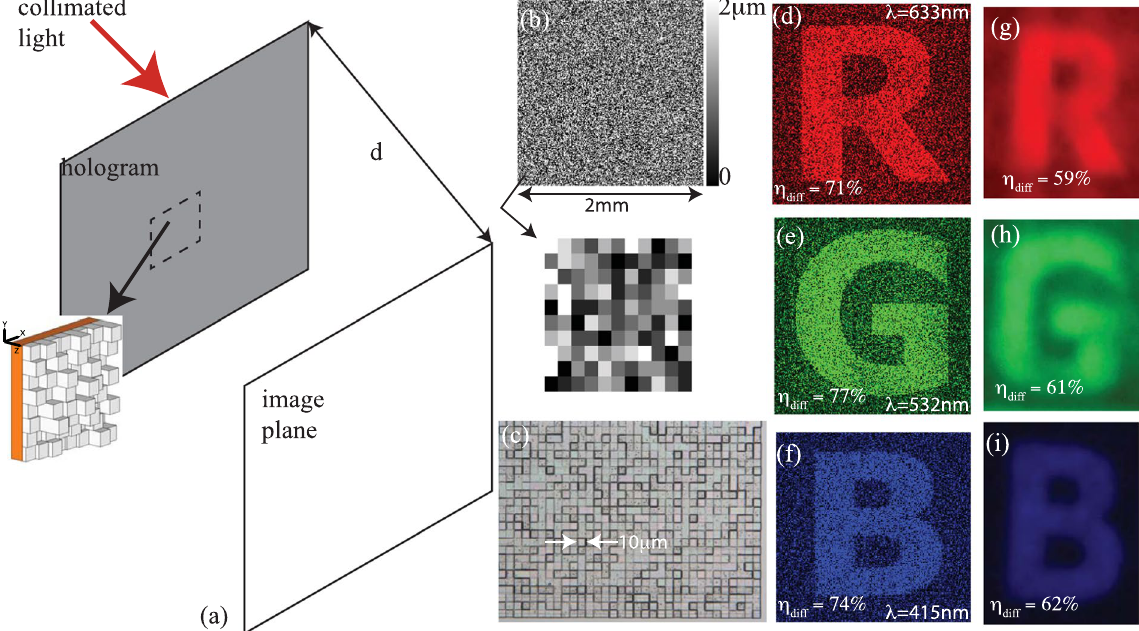
Figure 1. ( a ) Schematic of hologram. ( b ) Designed height map of color-encoded hologram. Bottom Inset: Magnified view of 11X10 pixels of bottom left corner. ( c ) Magnified optical micrograph of a small portion of the device. Simulated images at ( d ) λ = 633 nm, ( e ) λ = 532 nm and ( f ) λ = 415 nm are shown. The corresponding experimental images reflecting of a white opaque screen are shown in ( g )–( i ), respectively. The simulated and measured diffraction efficiencies are noted in each